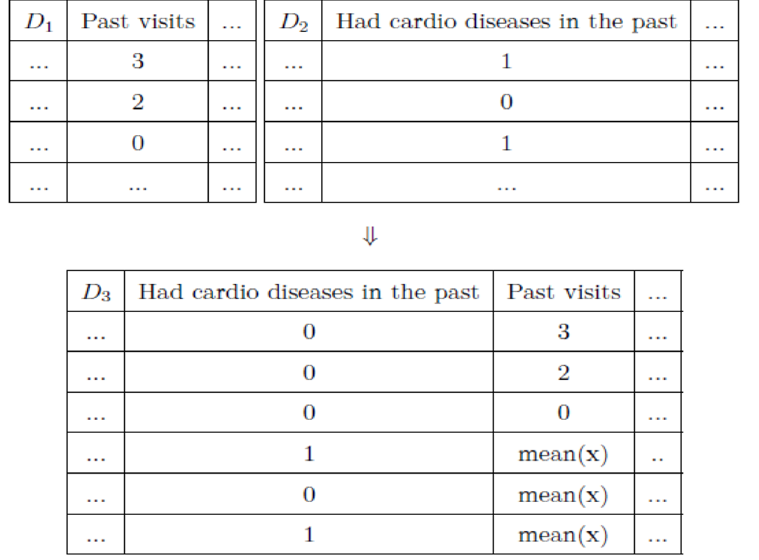
Figure 4. Two dependent features end up in one table, with filled values obscuring their dependency, making it a potential problem for the